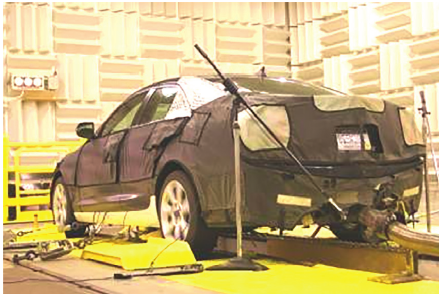
Figure 14: Application case of vehicle noise